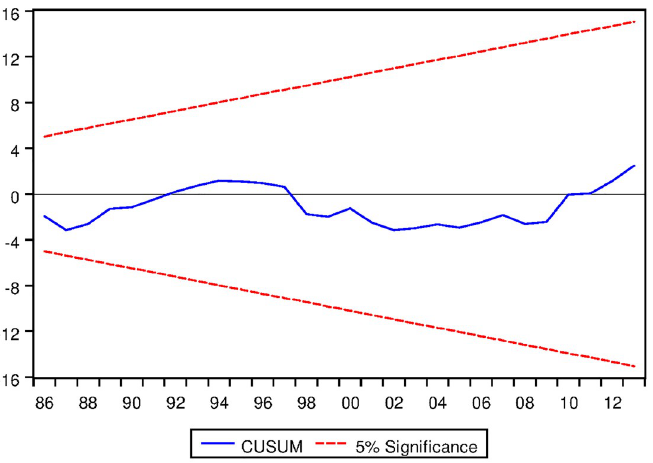
Fig 18. Stability diagnostic of cointegrating relationship for Japanese data with linear trend as fixed regressor under proposed framework.